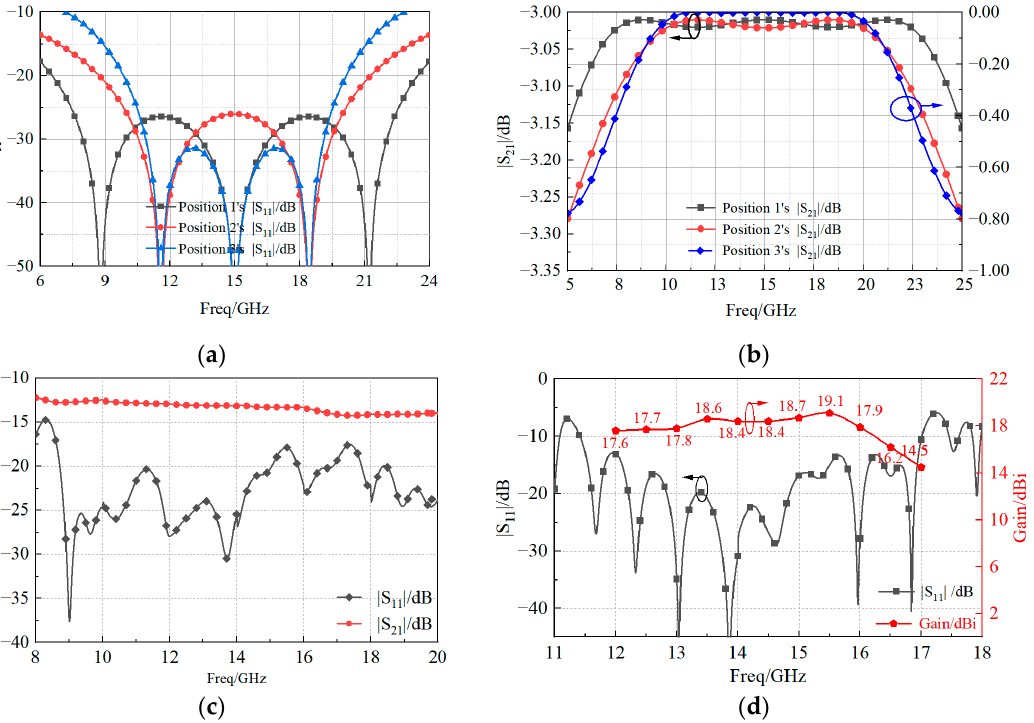
Figure 12. Simulated magnitude of the ( a ) reflection and ( b ) transmission coefficients of position 1, position 2, and position 3; the ( c ) whole | S 11 , S 21 | of the feeding network; and the ( d ) reflection coefficient and gain of the proposed antenna array.